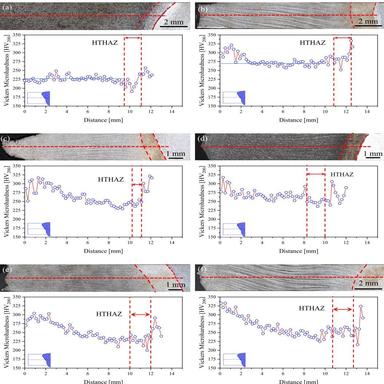
Vickers microhardness profiles in the IN600 alloy side (a) as-welded, and crept samples at (b) 150 MPa, (c) 157.5, (d) 165, (e) 180, and (f) 210 MPa.